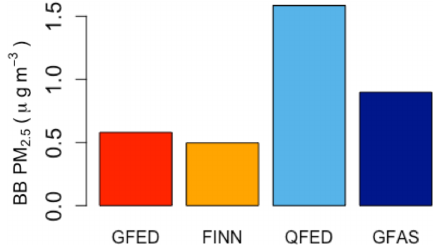
Figure 13. Bar plots of the 2012 annual mean population-weighted fire PM 2 . 5 exposure across the four inventories (GFED4s in red, FINN1.5 in orange, QFED2.4 in light blue, and GFAS1.2 in dark blue) across North America (Canada and CONUS only) at nested resolution. See Figure S6 for an analysis from 2012 to 2014 and for bar plots split out for Canada and the US at 2 × 2 . 5 ◦ .